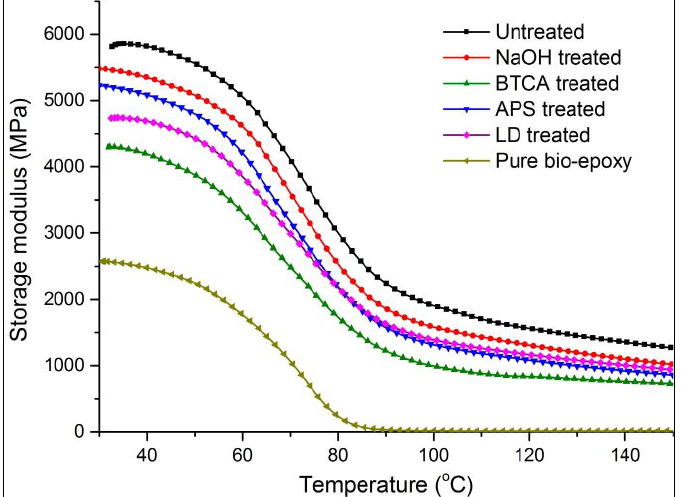
Figure 2. Variation of storage modulus of resin and flax reinforced epoxy (FE)